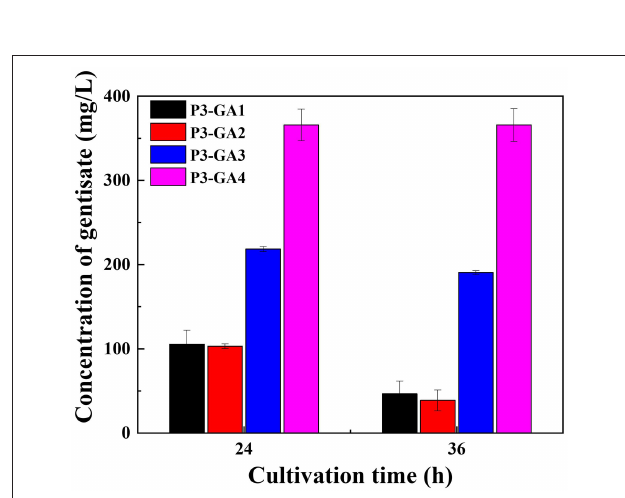
FIGURE 5 | Improvement of rate limiting steps for enhancement of gentisate